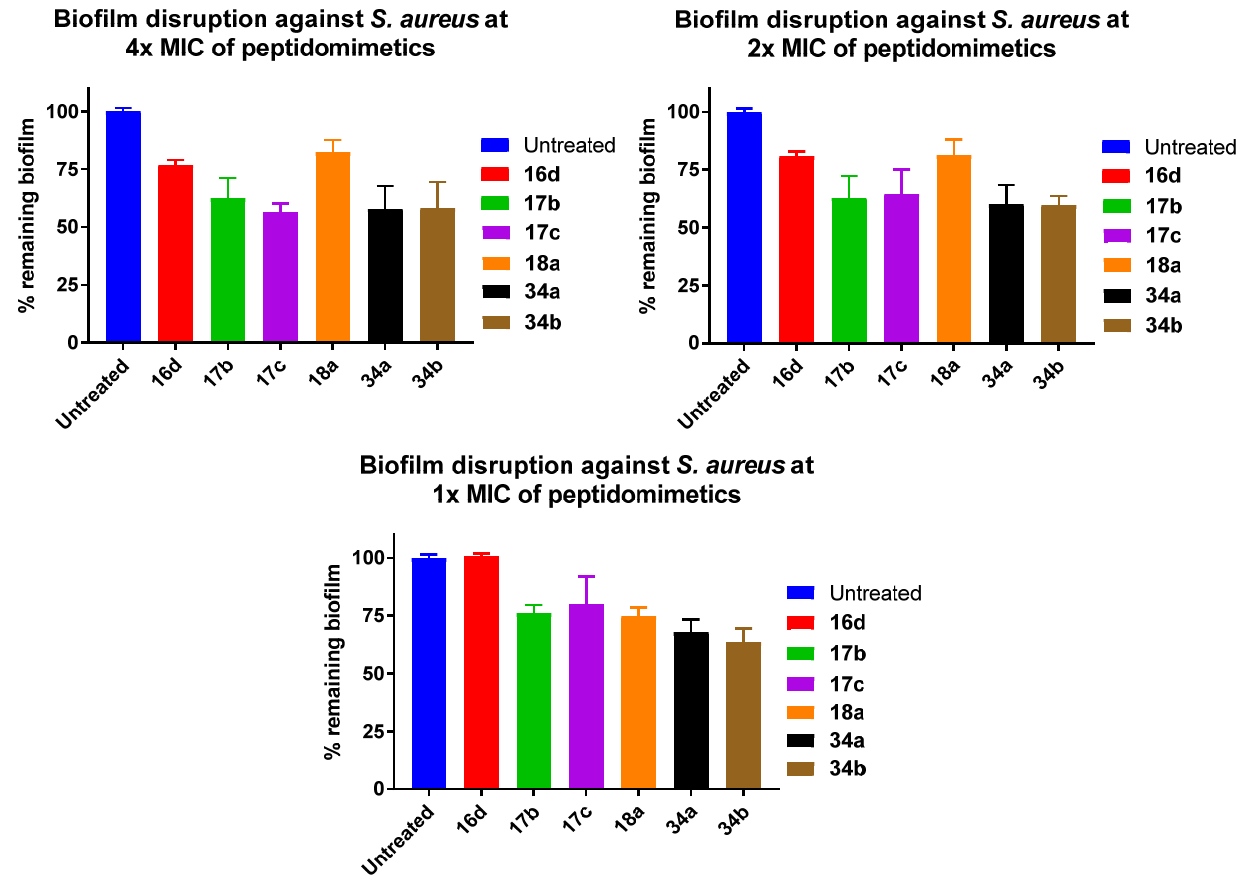
Figure 3. Percentage remaining S. aureus biofilms following 24 h treatment with peptidomimetics at 4 × ( top left ), 2 × ( top right ) and 1 × ( bottom ) MIC. Error bars represent the standard error of at least triplicates ( n ≥ 3).